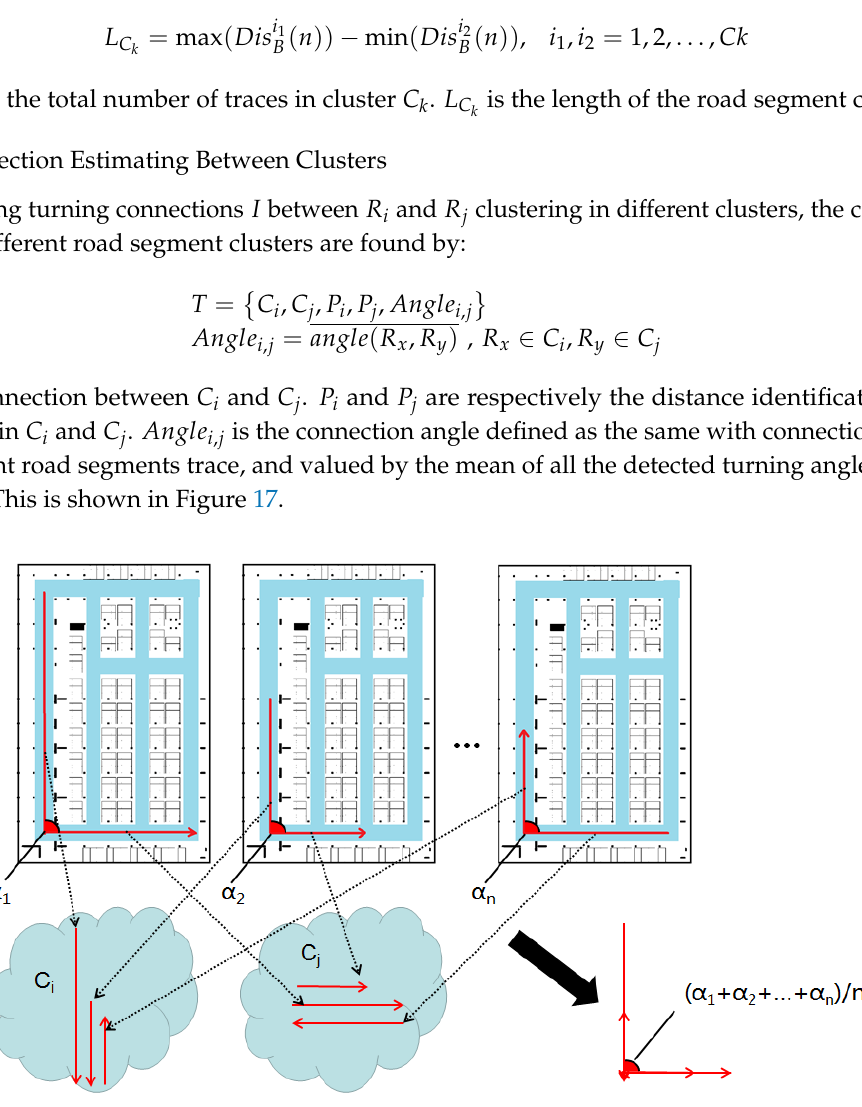
Figure 17. The process for estimating connection angle between clusters C i and C j